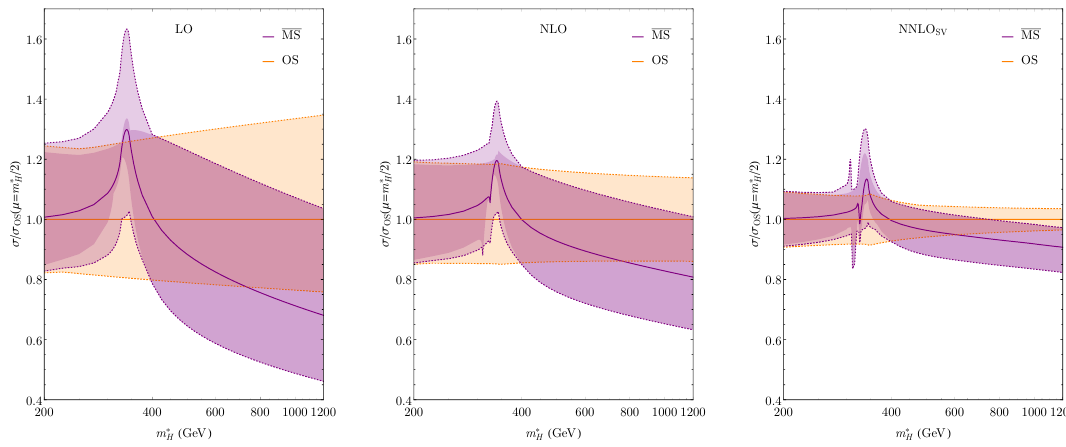
Figure 2 . Ratio of the MS (purple) and OS (orange) cross sections at LO (left), NLO (center) and NNLO SV (right). The bands denote the scale uncertainties, computed using 7-point and 15- point variations in the OS and MS schemes, respectively. The MS uncertainties corresponding to a restricted 7-point variation with the contraint µ = µ are indicated with the darker purple m R